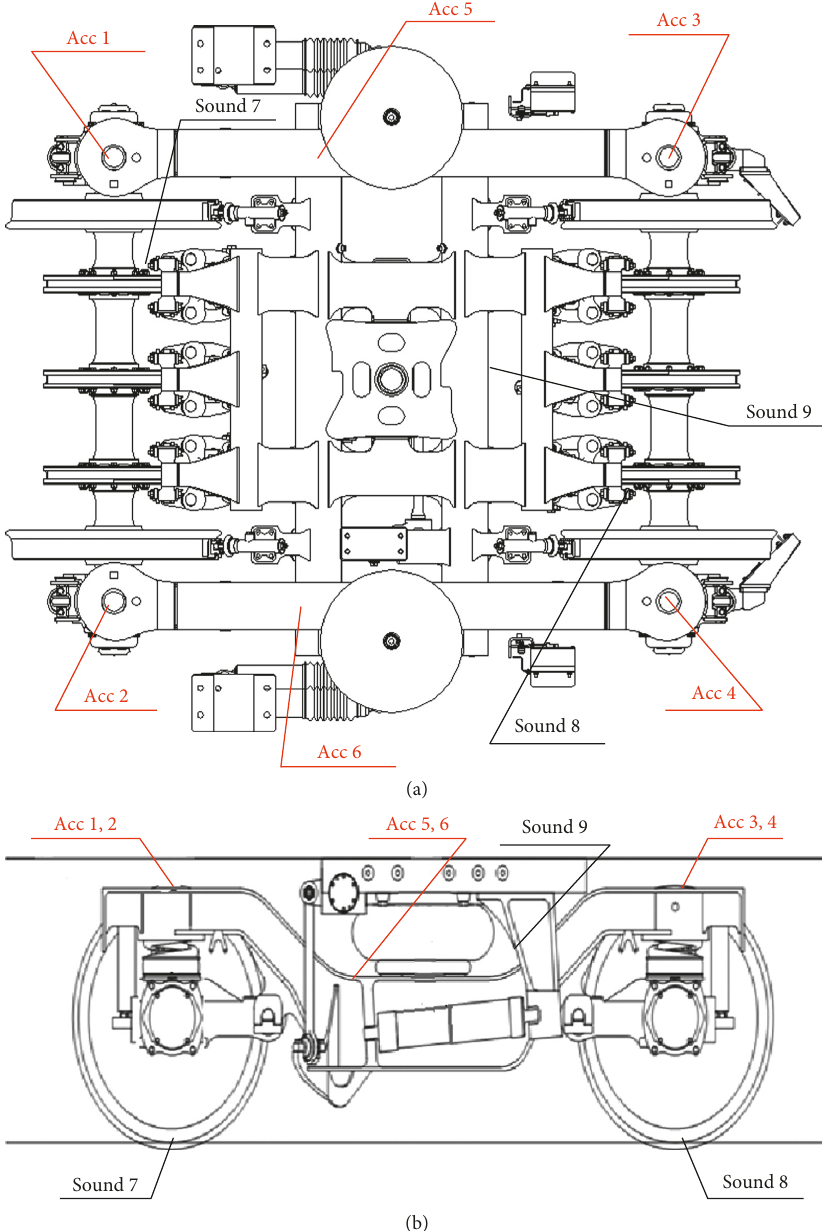
Figure 2: Measuring point layout. (a) Top view. (b) Side